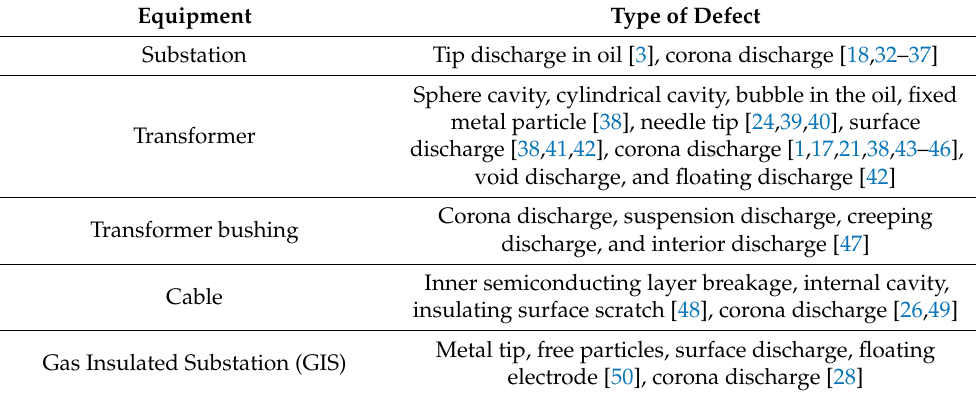
Table 1. Common defects for power equipment.